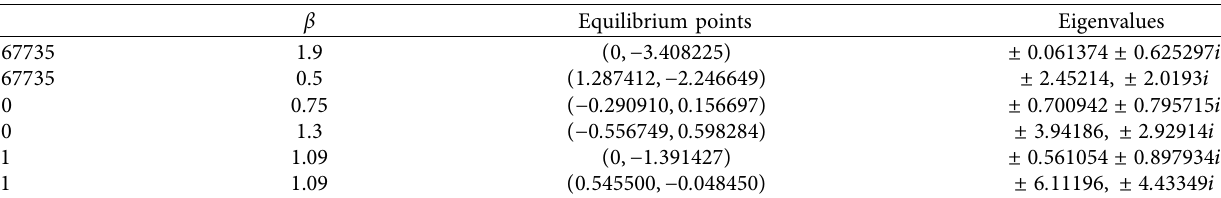
Figure 20: Case I: stability regions when (a) α � 0 . 1 and (b) α � 1 . 5. Table 2: Equilibrium points and stability analysis for case I.